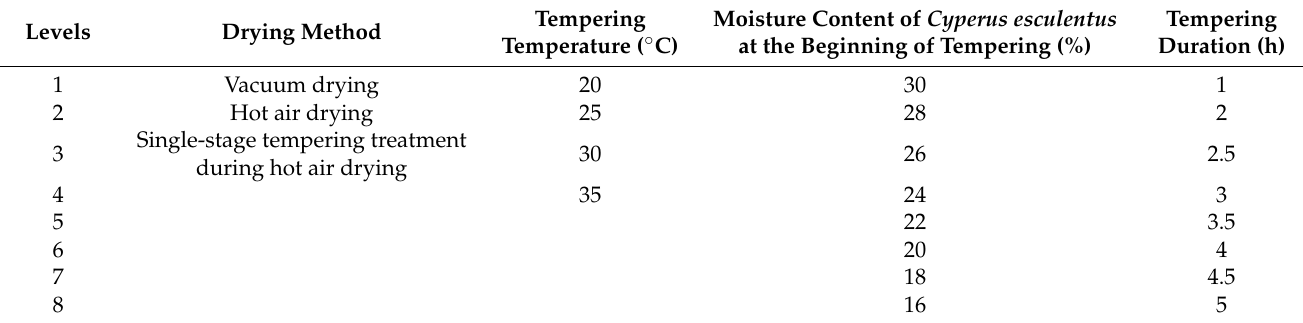
Table 2. Experimental scheme of single-factor experiment.